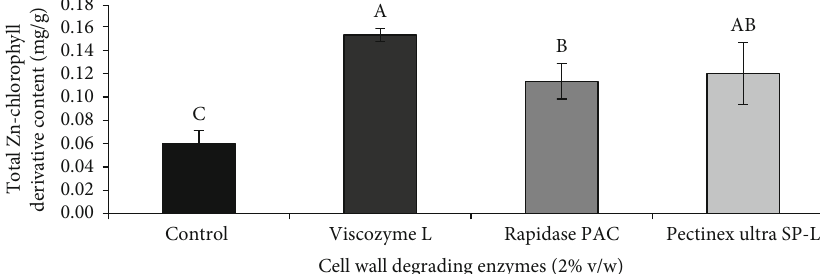
Figure 2: TZCD (mg/g FW) content of Zn-amaranth puree lique fi ed with 2% of di ff erent cell wall degrading enzymes (% v/w) and incubated at pH 5 and 45 ° C for 24 h. Data are expressed as the means ± standard deviations of triplicates. Means with the same letter in each column mean not signi fi cantly di ff erent ( p < 0 : 05 , ANOVA).